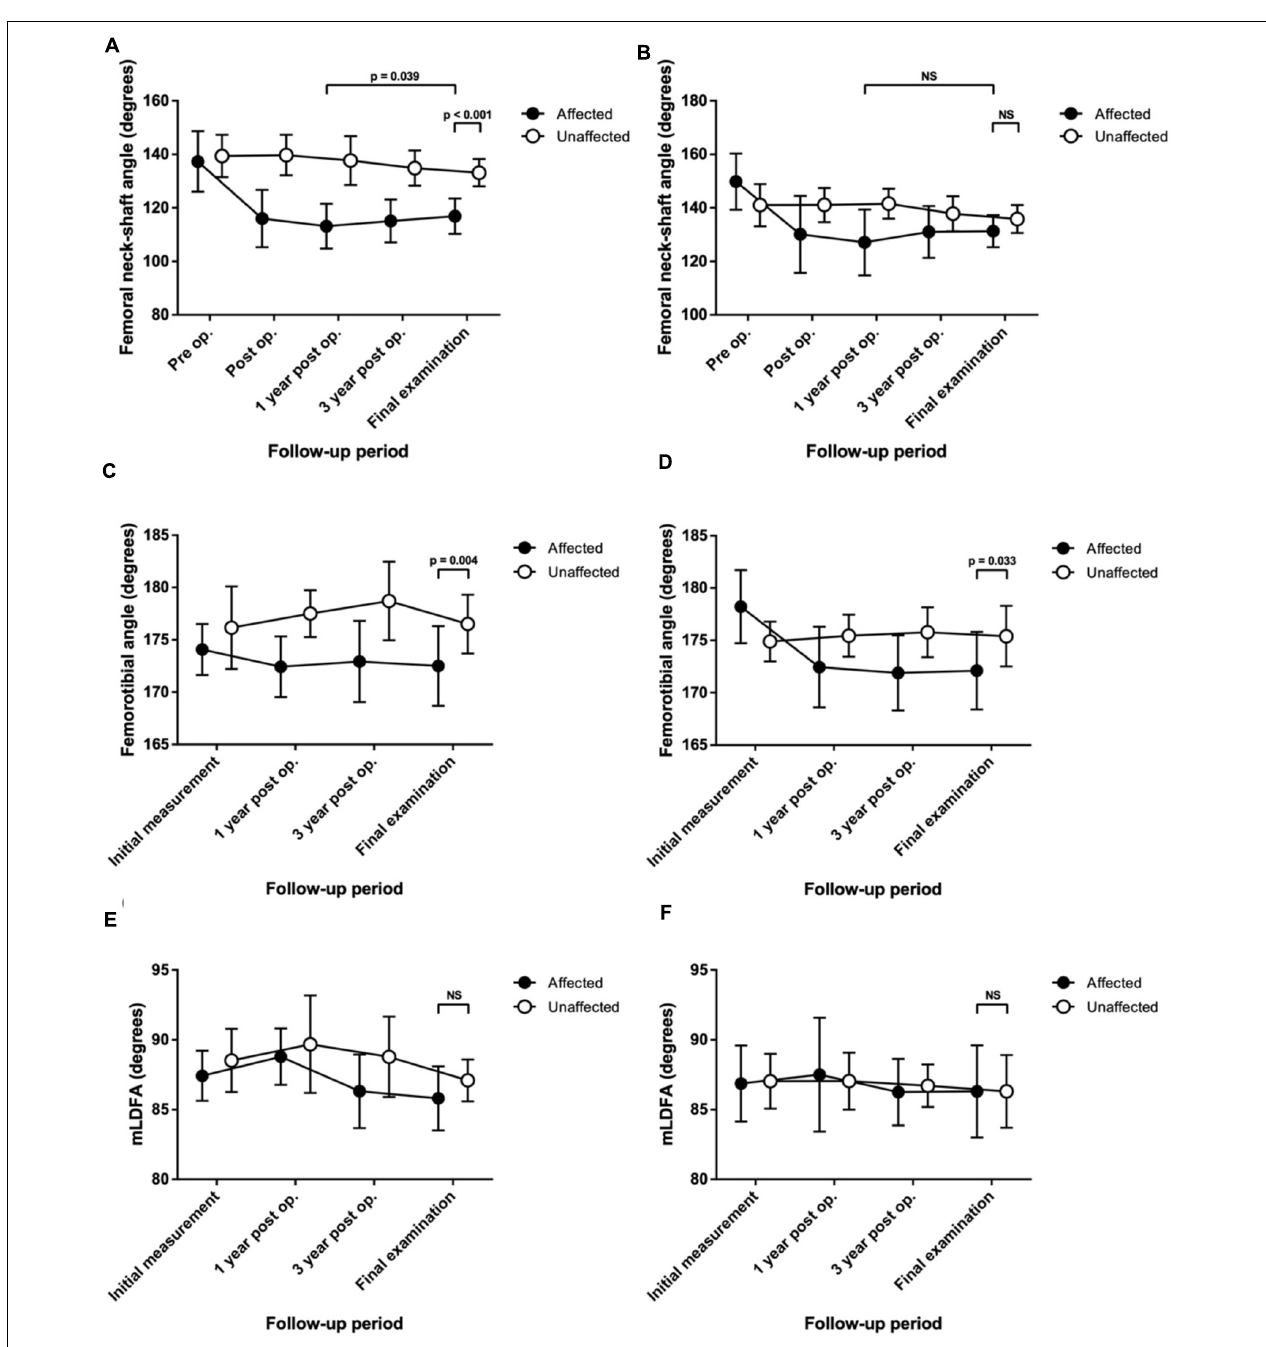
FIGURE 2 | Serial change in the radiological measurements up to the final assessment in patients with Legg–Calvé–Perthes disease (LCPD) or developmental dysplasia of the hip (DDH) who were treated with proximal femoral varus osteotomy (PFVO) and Pemberton osteotomy. (A) Femoral neck-shaft angle of patients with LCPD. (B) Femoral neck-shaft angle of patients with DDH. (C) Femorotibial angle of patients with LCPD. (D) Femorotibial angle of patients with DDH. (E) Mechanical lateral distal femoral angle (mLDFA) of patients with LCPD. (F) mLDFA of patients with DDH. NS, not